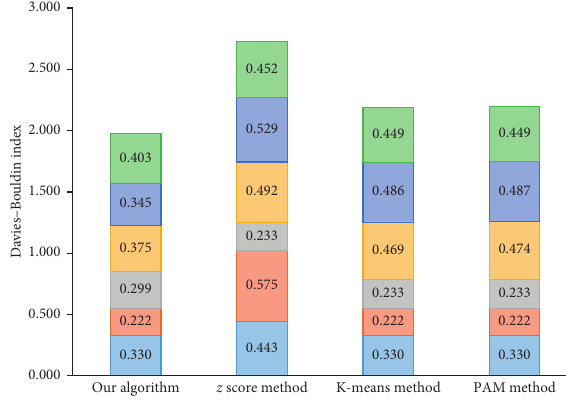
Figure 8: Overall performance of each method. Table 13: Grading scheme selection